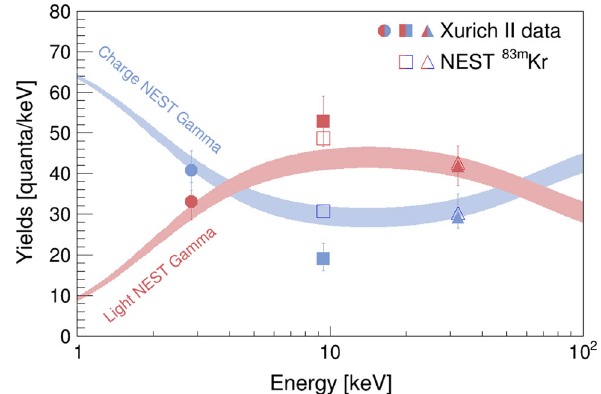
Fig. 12 Comparisonoftheobtainedcharge(blue)andlight(red)yields from 37 Ar and 83m Kr lines at 968V/cm to the NEST v2.0 gamma and 83m Kr model. The uncertainty bands reflect the intrinsic systematics of the gamma model